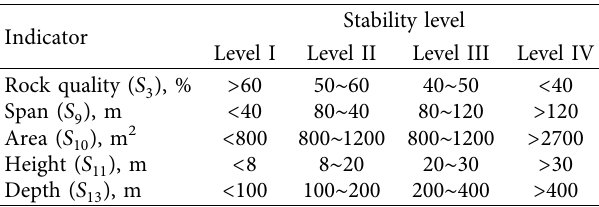
Table 1: Classification and assignment of quantitative indexes for goaf stability